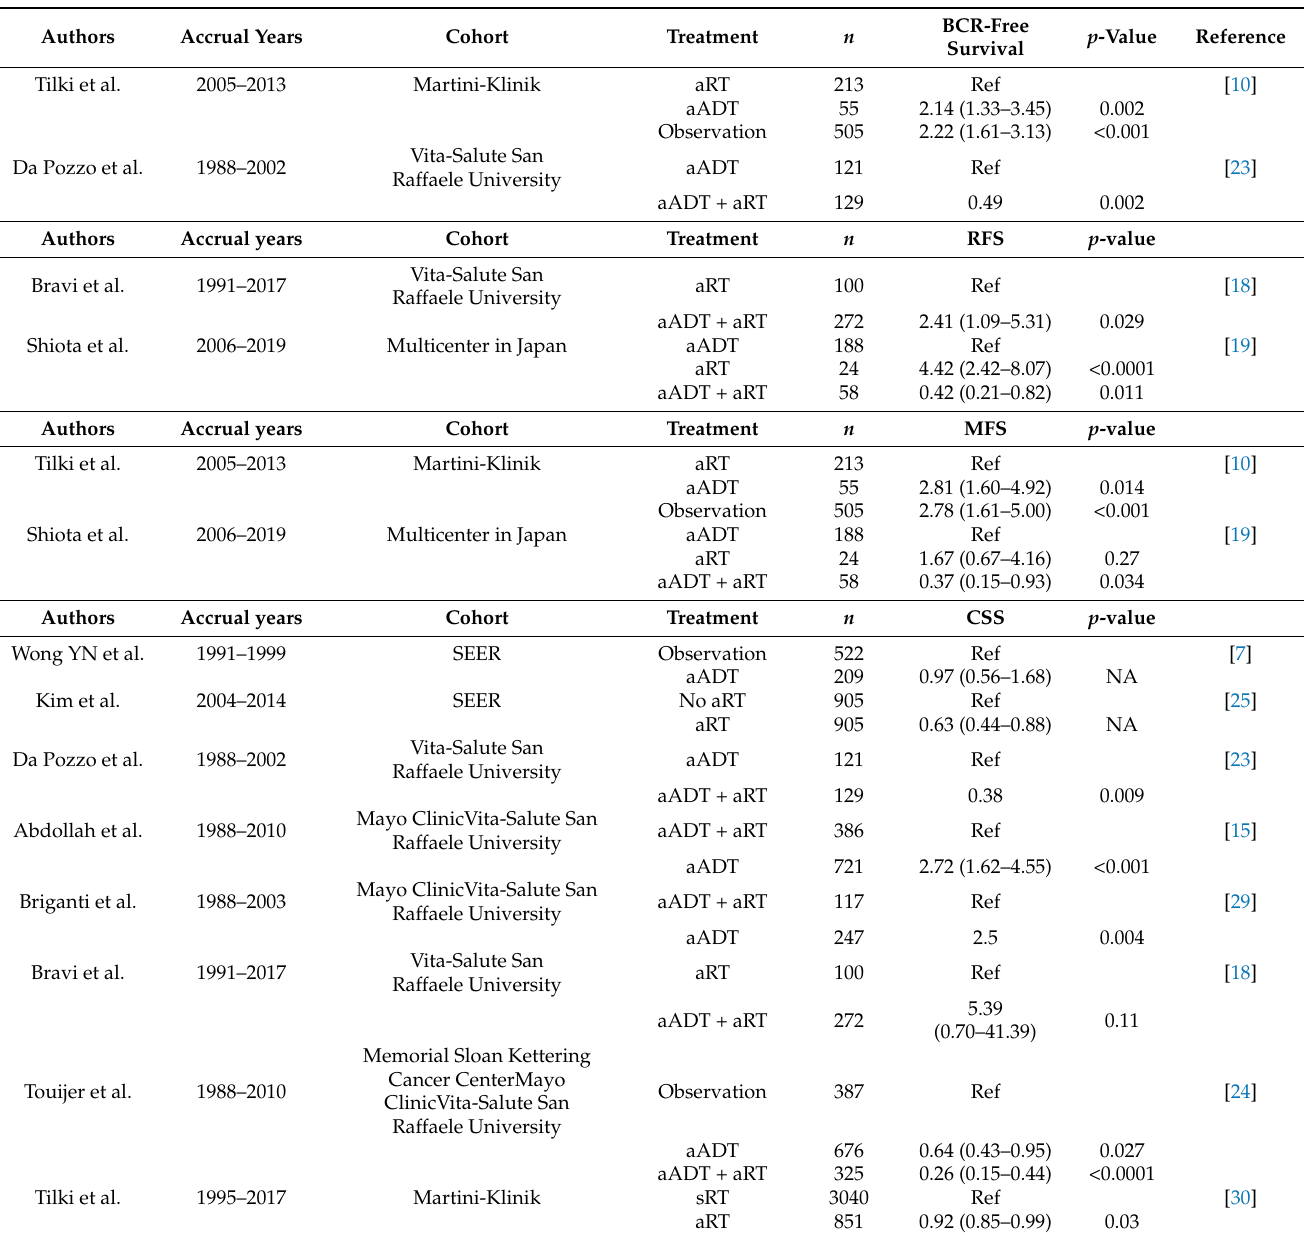
Table 2. Hazard ratio for prognosis by multivariate analysis or propensity score matched analysis in pN1